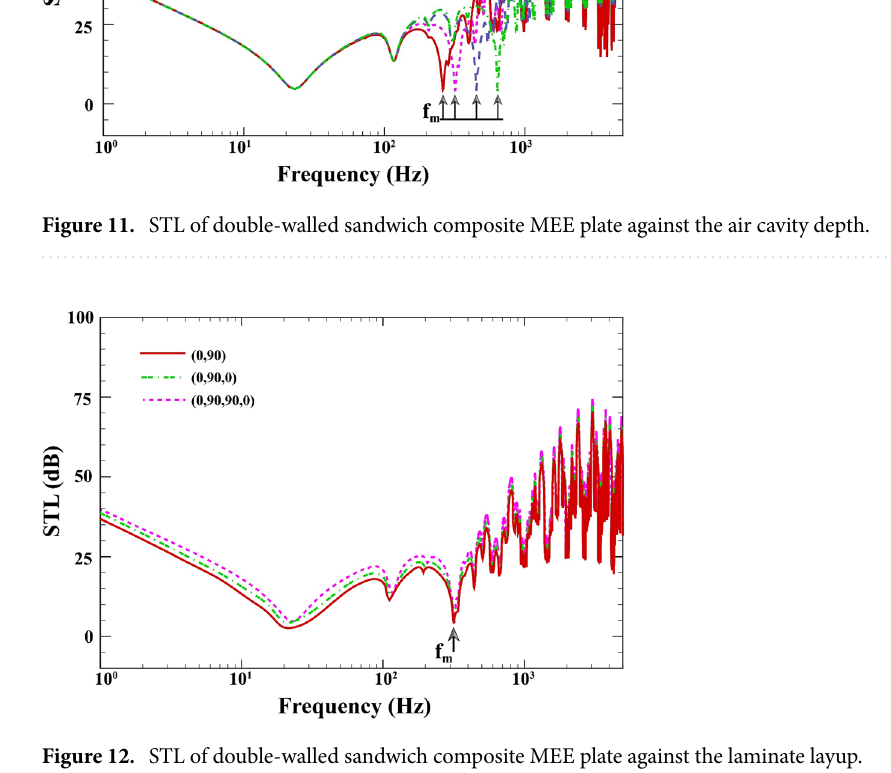
Figure 8 indicates the variations of STL behavior of the double-walled struc- ture against the different values of the viscoelastic medium’s damping coefficient when 0.8 m, L 0.02 m, h m 0.0005 m, h c 0.001 m, β 45 ◦ , ( 0 / 90 / 90 / 0 ) , V 0 V, ψ 0 0 A, k W 0 N / m 3 , � T 0 K. It is observed a b = = = = = = = = = = from this figure that by considering damping coefficient from 0 Ns / m 3 to 2000 Ns / m 3 (see Refs. 59,60 for given